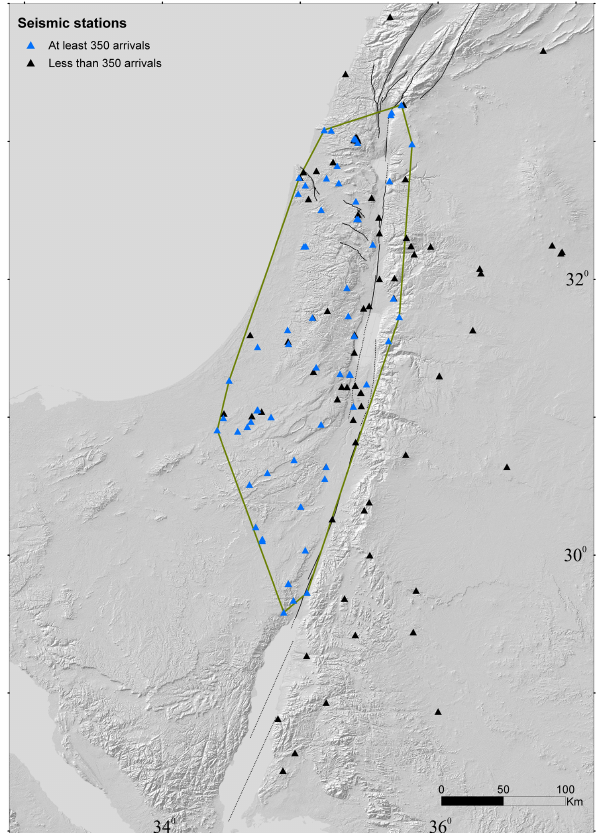
Figure A1. Seismic stations utilised for recording the earthquakes of the examined catalogue, and the ensuing seismic network coverage area. The spatial distribution of the stations is temporally dependent. Stations that recorded less than 350 arrivals are in black, while stations that recorded more than 350 arrivals are in blue. Green lines mark the borders of the seismic network coverage area as defined in this